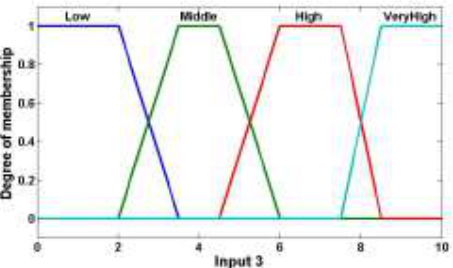
Figure 4. Membership functions of the Input 3